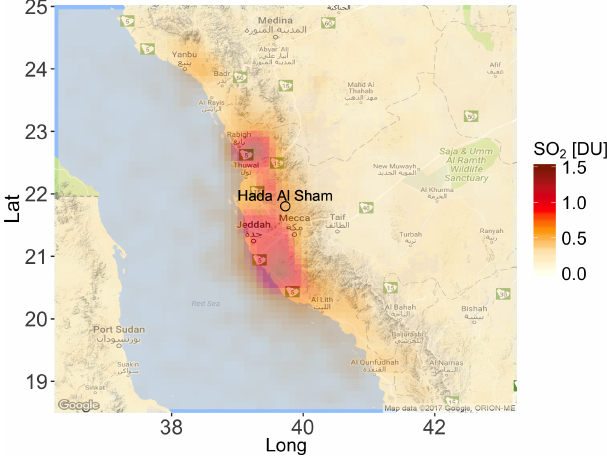
Figure 3. Average concentration of SO 2 from the OMI Level 2 SO 2 planetary boundary layer product (Li et al., 2013) in the surround- ings of Hada Al Sham during NPF days. The concentrations are shown in Dobson units (1DU = 2 . 69 × 10 16 moleculescm − 2